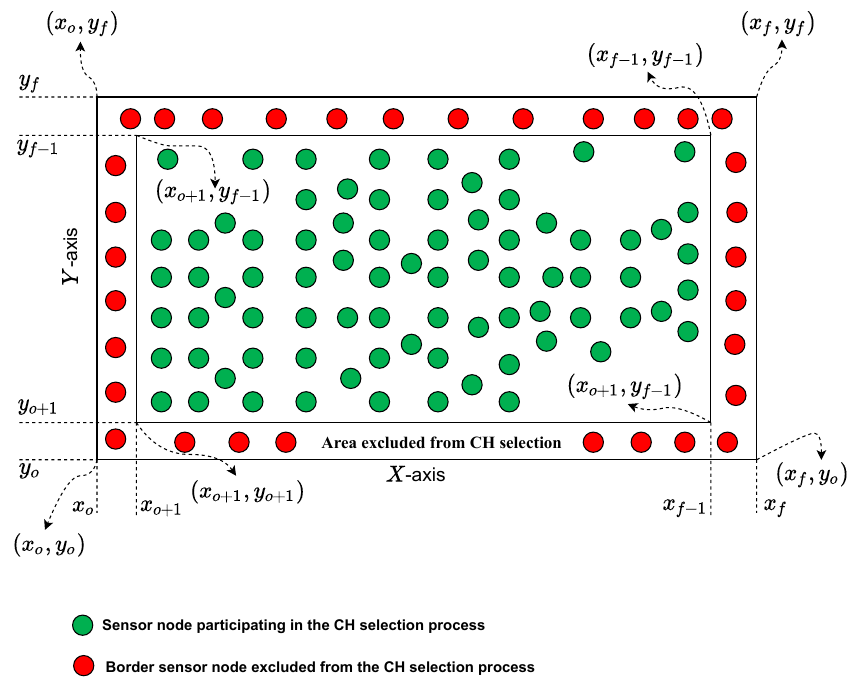
Figure 4. Border sensor nodes distribution in a sensing